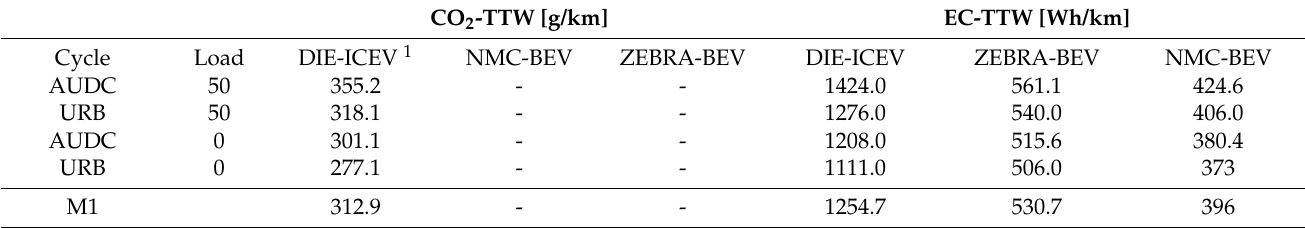
Table 5. CO 2 emissions and Energy Consumption TTW referring to the M1